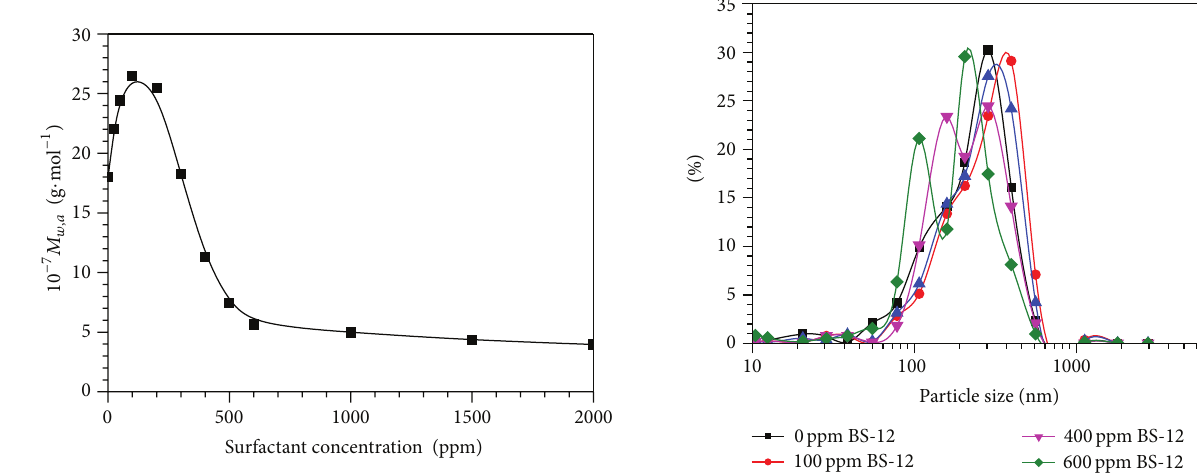
Figure 7: Effect of BS-12 concentrations on apparent weight average molecular weight ( 𝑀 𝑤,𝑎 ) of HAPAM.